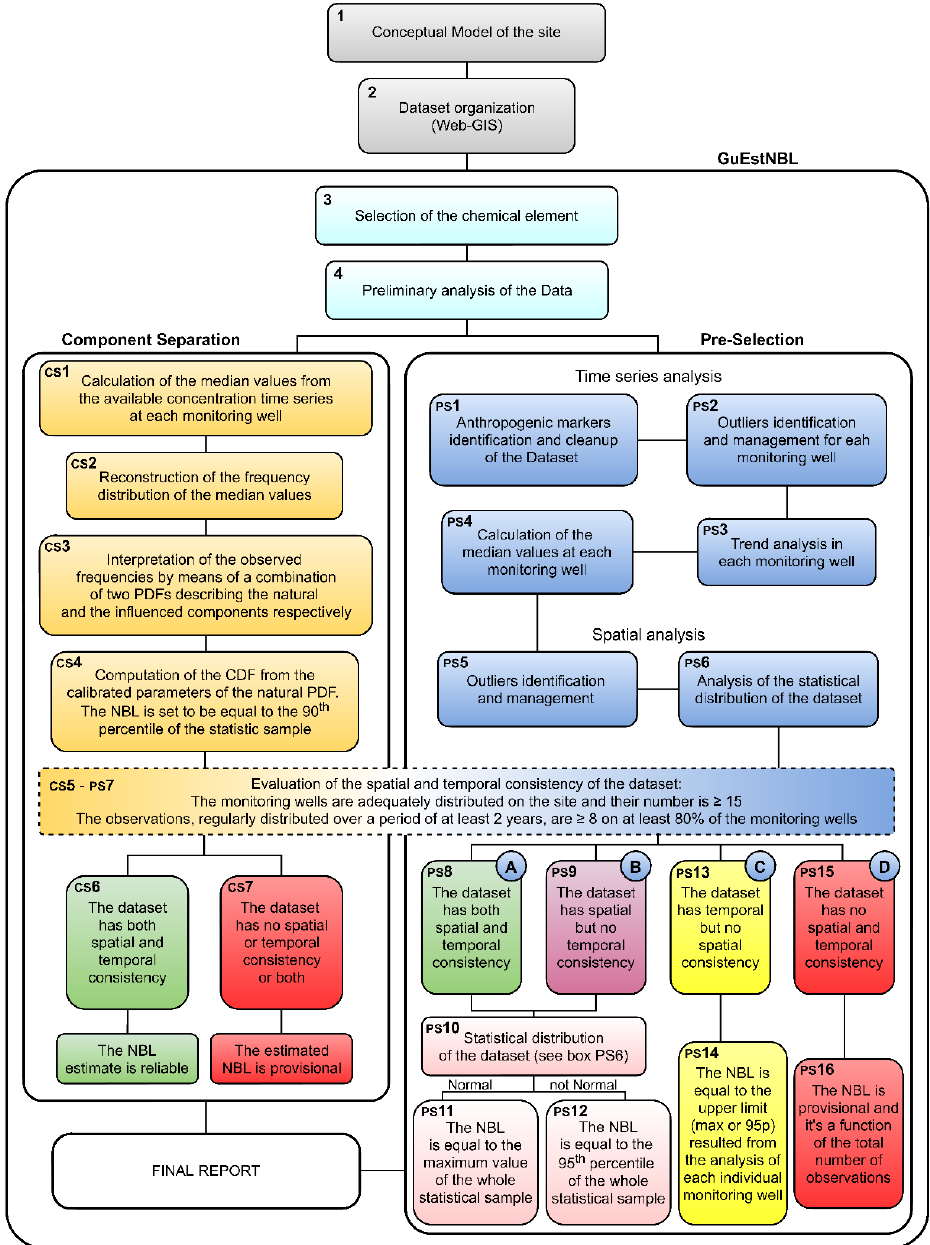
Figure 1. Scheme of the procedure implemented to estimate the natural background levels (NBLs) of aquifers. The blocks numbering (bold characters at the top right of each box) having the CS prefix refers to the procedures included into the component separation method, while the PS prefix is related to the pre-selection method. Other terms appearing in the scheme are: Web-GIS which stands for online geographical information system; PDF which stands for probability density function; CDF which stands for cumulative distribution function; bold letters A, B, C, D indicating four di ff erent cases in which the dataset can fall; 95p which stands for 95th